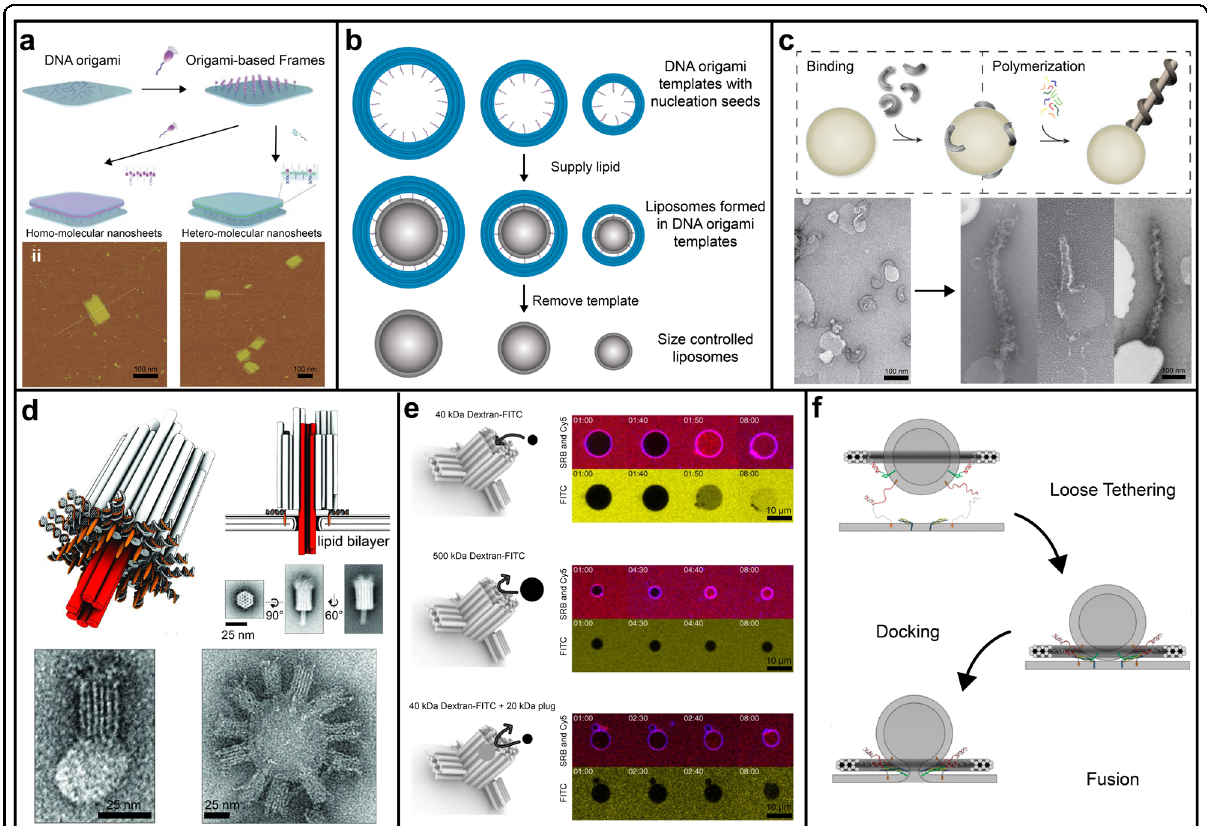
Fig. 4 Regulating lipid membranes with DNA origami structures. a Frame-guided assembly of amphiphilic molecules on DNA origami nanosheets. (Reproduced with permission 136 , Copyright 2016, Wiley-VCH). b Synthesis of size-controlled liposomes with DNA origami templates. c Vesicle tubulation controlled by the DNA origami nanosprings. DNA origami monomers are absorbed onto the vesicle with the help of amphipathic peptides and polymerized into nanosprings via linker strands, which can shape vesicles into tubules. (Reproduced with permission 143 , Copyright 2018, Wiley-VCH). d A synthetic lipid membrane channel created with a DNA origami structure inserted into a lipid membrane via cholesterol moieties. (Reproduced with permission 145 , Copyright 2012, AAAS). e A synthetic DNA origami channel equipped with a size-selective gating system for the transport of macromolecules. (Reproduced with permission 150 , Copyright 2019, Macmillan Publishing Ltd.). f A DNA origami- SNARE hybrid platform for exploring the membrane-fusion process. (Reproduced with permission 153 , Copyright 2016, American Chemical